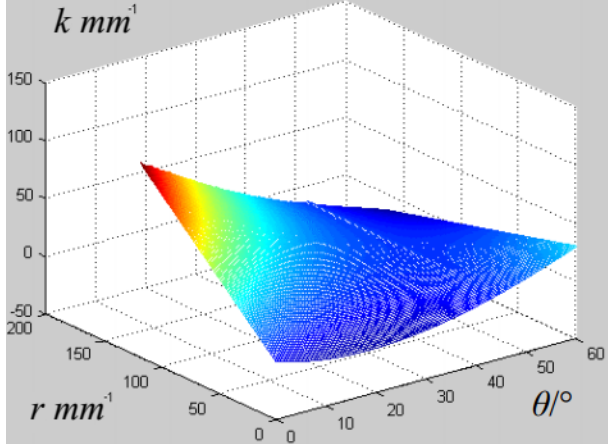
Figure 14. Kinematic margin of leg 1 varying with twisting angle θ and lateral distance r between hip 1 and the original foothold.